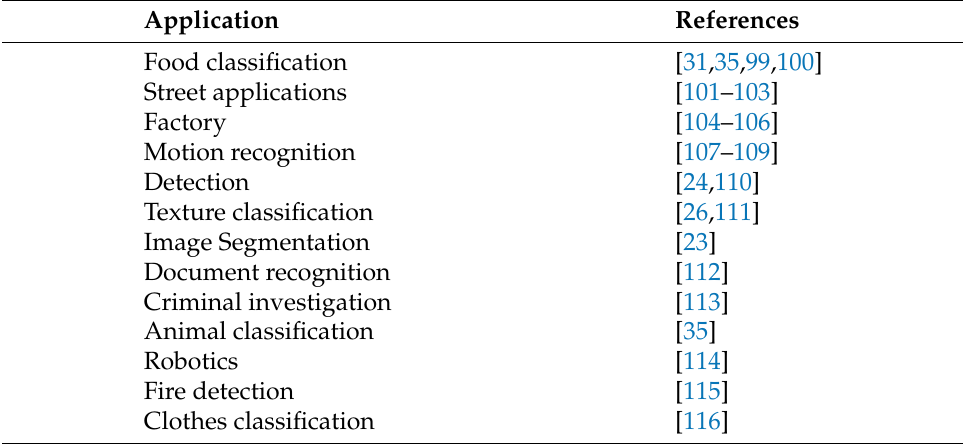
Table 8. Other application scenarios found in the primary studies.